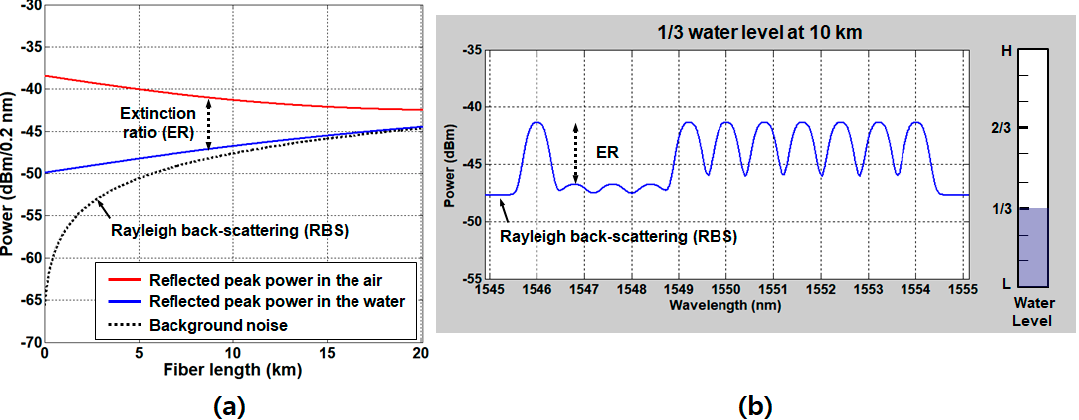
Figure 10. ( a ) Received optical power density as a function of the fiber length, where the RBS power approaches the signal power, and ( b ) the optical spectrum of the 1/3-full water level (3 height steps) at a 10-km fiber length. Adapted from Lee et al. [50].